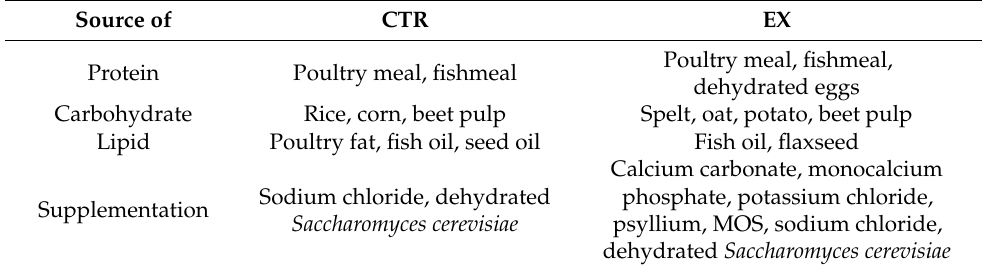
Table 1. Diet ingredients.